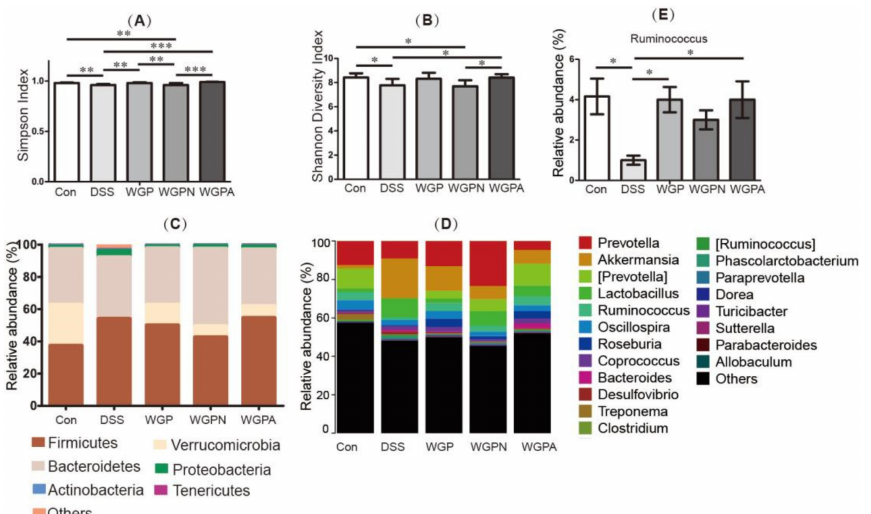
Figure 4. Diversity and composition analysis of the gut microbiota: ( A ) Simpson index; ( B ) Shannon index; ( C ) gut microbiota composition at the phylum level; ( D ) gut microbiota composition at the genus level; ( D ) relative abundance of Ruminococcus. The bars represent the mean ± SD ( A , B , E ) or the mean ± SEM ( C , D ), n = 8.* p < 0.05, ** p < 0.01, and *** p < 0.001.Con, control group; DSS, colitis group; WGP, WGP treatment group; WGPN, WGPN treatment group; WGPA, WGPA treatment group.